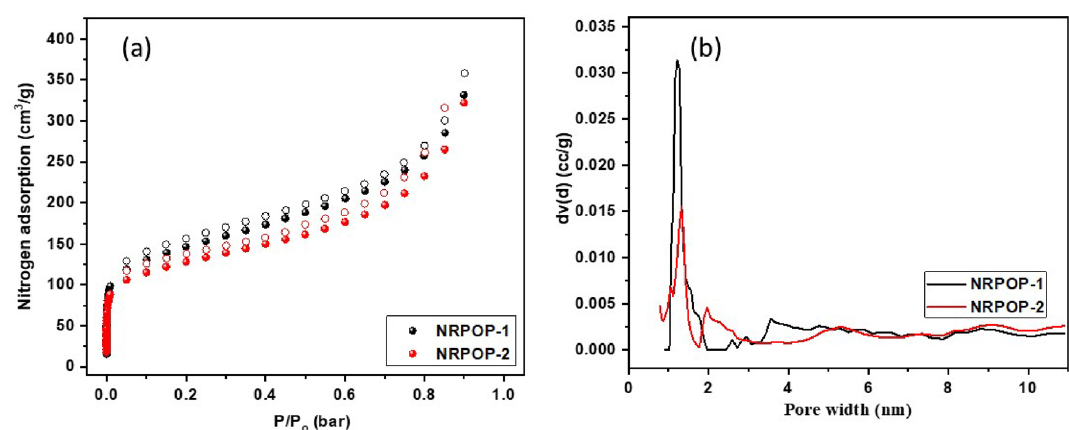
Figure 3. N 2 adsorption–desorption isotherms ( a ) and pore size distribution curves ( b ) of NRPOP-1 and NRPOP-2.